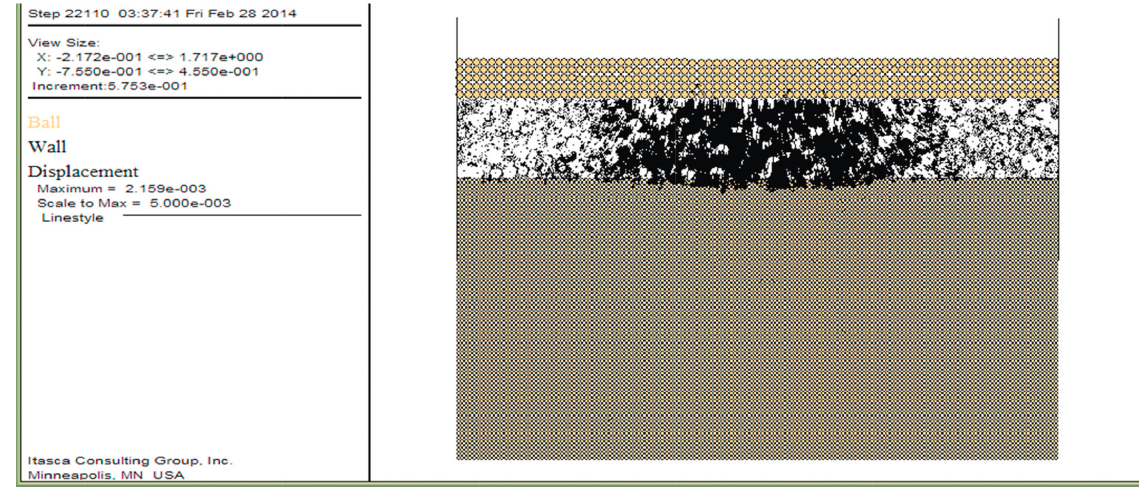
Figure 10: Deformation characteristics of the graded aggregate base layer.